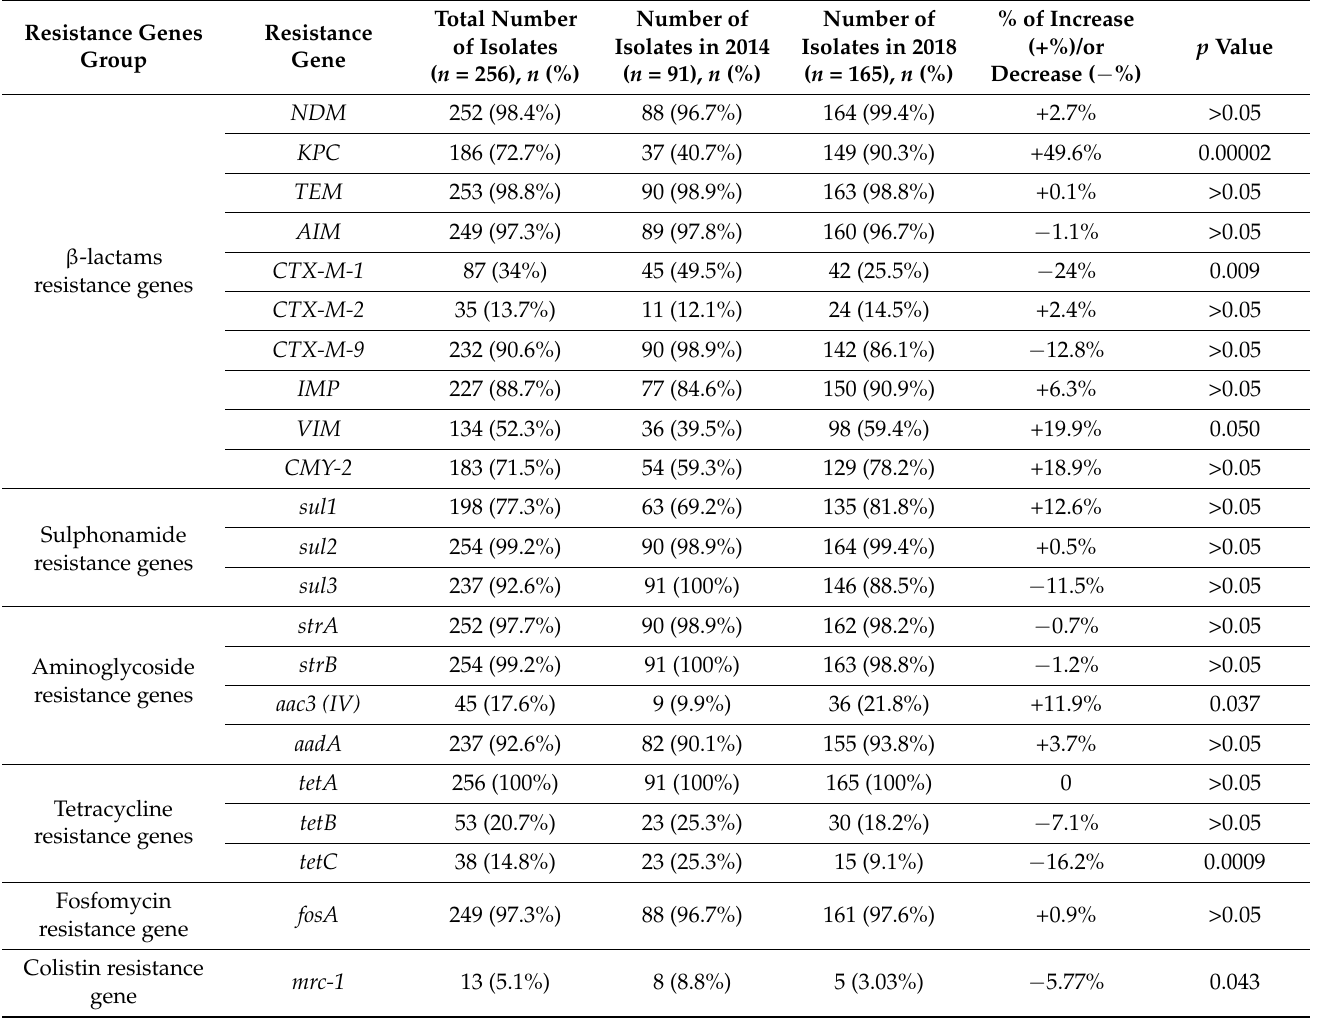
Table 2. Distribution of different antibiotic resistance genes in 2014 and